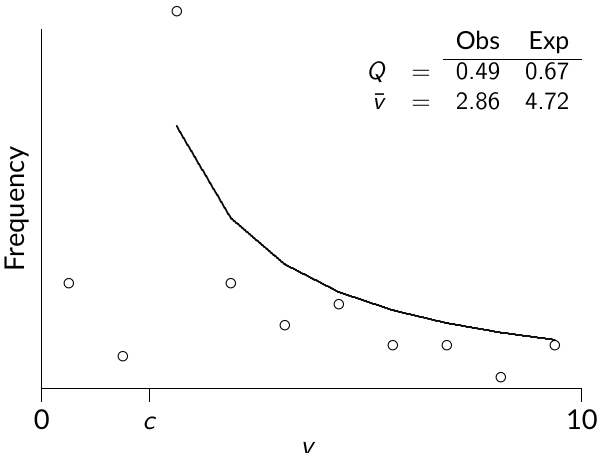
Figure 9 – The Nash equilibrium (solid line and values under “Exp”) compared with data from Fig. 2. In the experiment, K = 4 , v ranged from 0 to 10, and “going fishing” yielded payoff c = 2 . In the model, payoffs are re-expressed as fractions of the maximum payoff, so that c and v both lie between 0 and